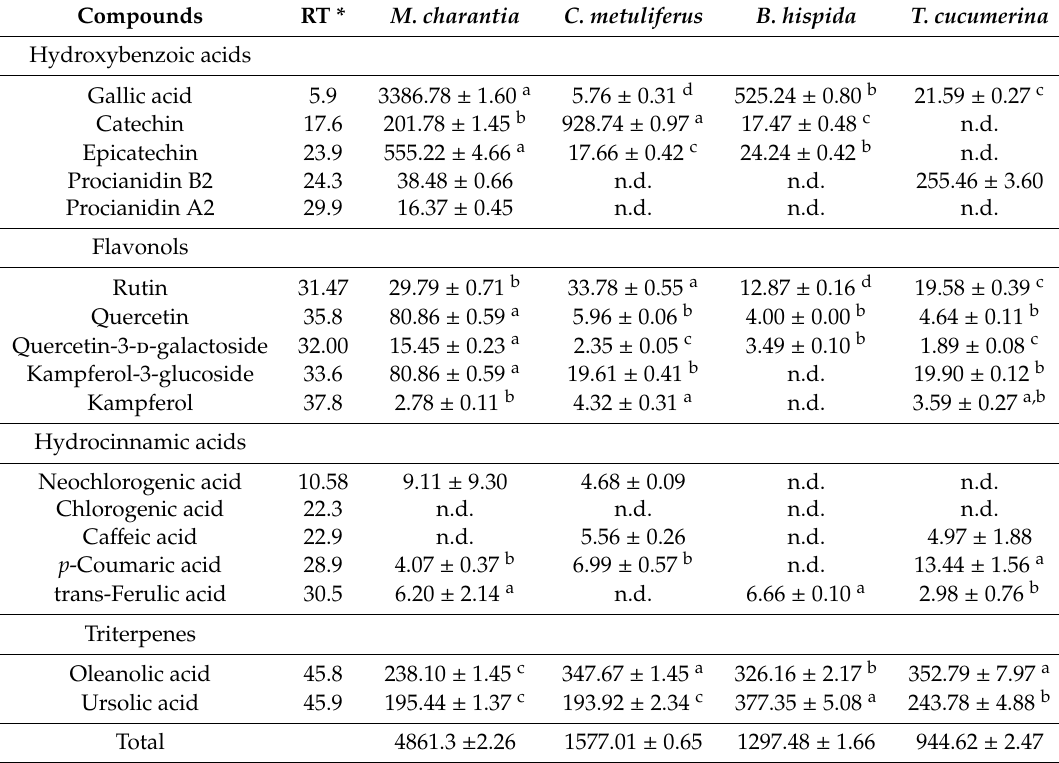
Table 1. Chemical composition of fresh juices (expressed as mg kg − 1 ± standard deviation).